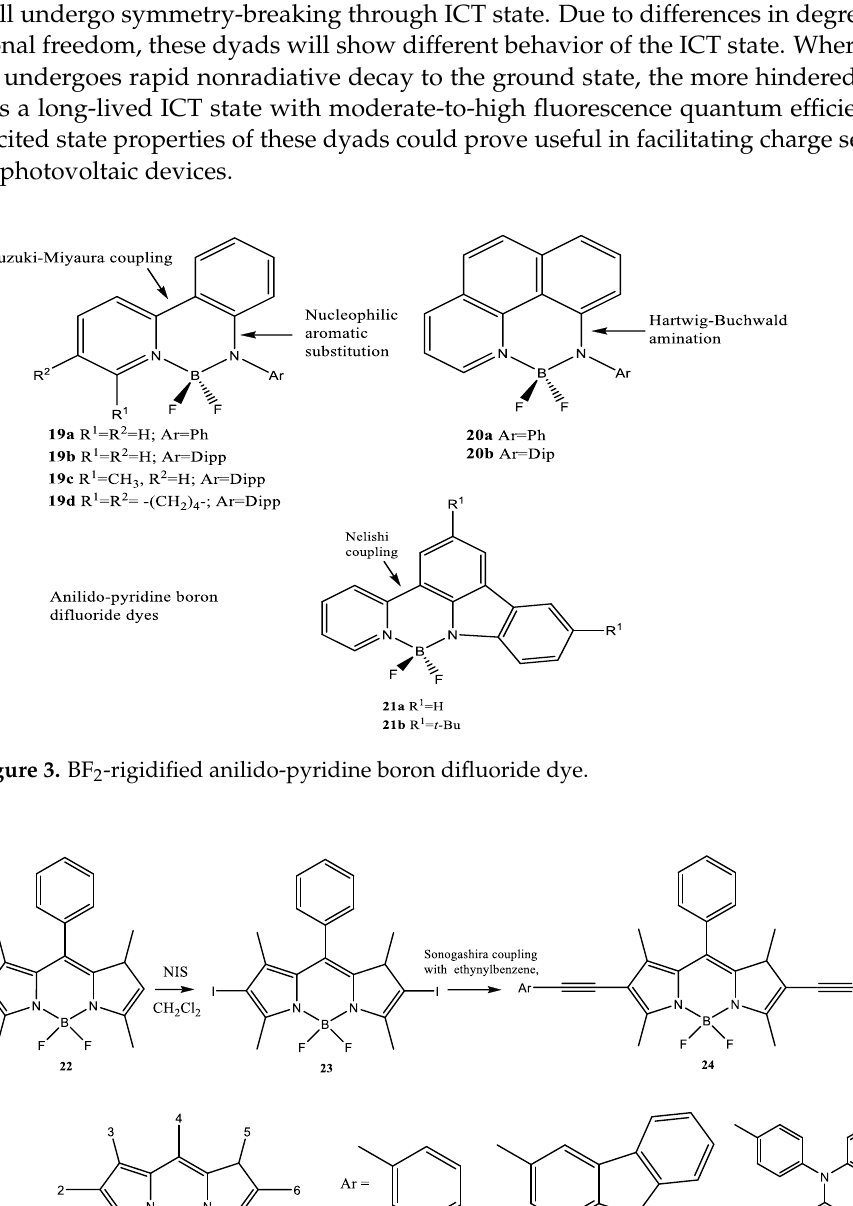
Figure 4. Boradiazaindacene derivatives of 24a , 24b , 24c .